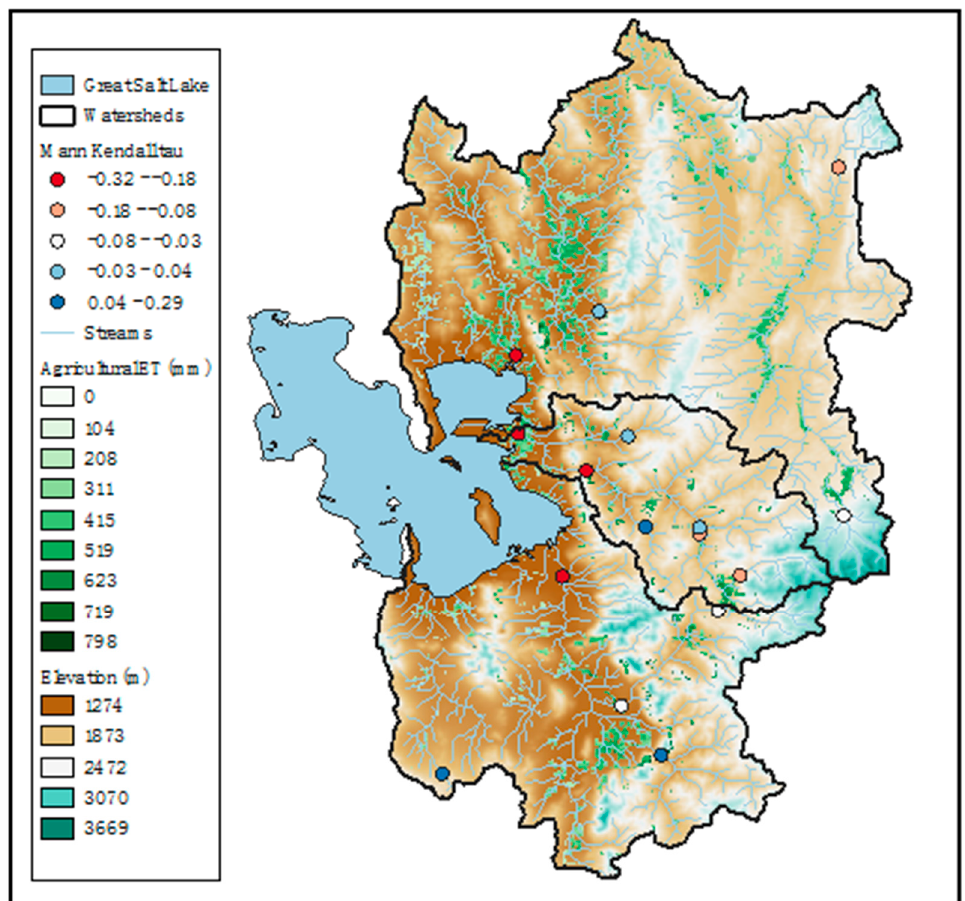
Figure 2. River discharge trends and irrigated agriculture in the Great Salt Lake watershed. Dots show long-term ( ≥ 50 year) discharge trends through 2018 in 16 rivers. Streamflow is steady in low order headwater streams. Only higher order rivers that discharge into the lake have sharply decreasing streamflow. This is consistent with increasing water consumption from irrigated agriculture. (Mann Kendall tau values indicate the strength and direction of a trend over time.)